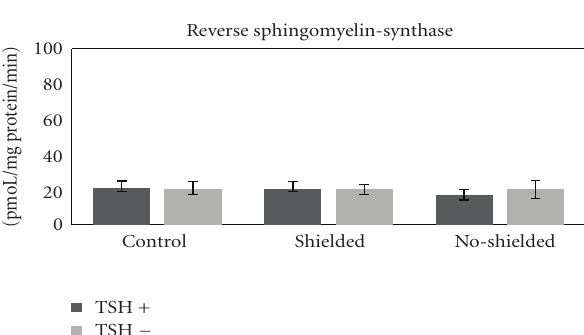
Figure 2: Neutral-sphingomyelinase, phosphatidylcholine- specific phospholipase C, sphingomyelin-synthase, and reverse sphingomyelin-synthase activities in purified nuclei of FRTL-5 cell cultured in the presence of TSH (TSH+). Data are expressed as pmol/mg protein/min and are the mean ± S.D. of three samples performed in duplicate. ∗∗ P < . 001 versus control